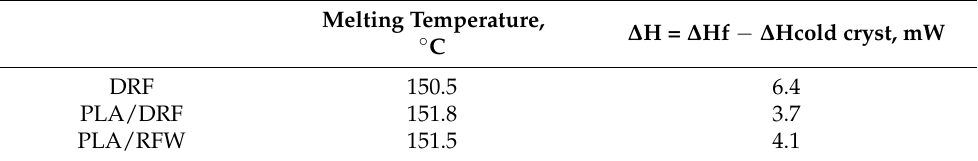
Figure 5. DSC trends of neat PLA and PLA containing 10%wt. of DRF and RFW. Table 2. Melt temperature, T °C, and fusion enthalpy, ∆H, on the second heating scan for neat PLA and PLA containing DRF and RFW.